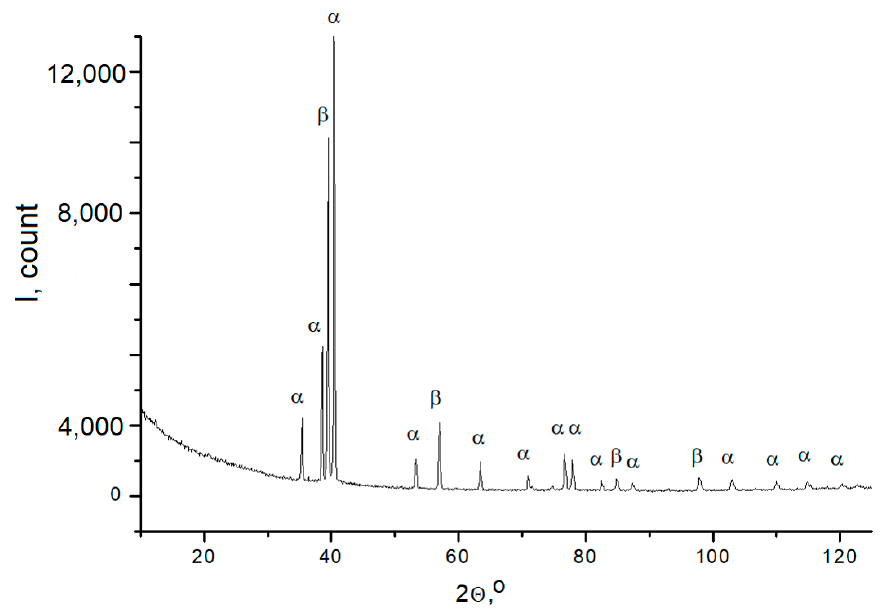
Figure 8. X-ray di ff raction of a hot-pressed biphase Ti-Al-Mo-V alloy. Figure 8. X-ray diffraction of a hot-pressed biphase Ti-Al-Mo-V alloy. Figure 8. X-ray diffraction of a hot-pressed biphase Ti-Al-Mo-V alloy.